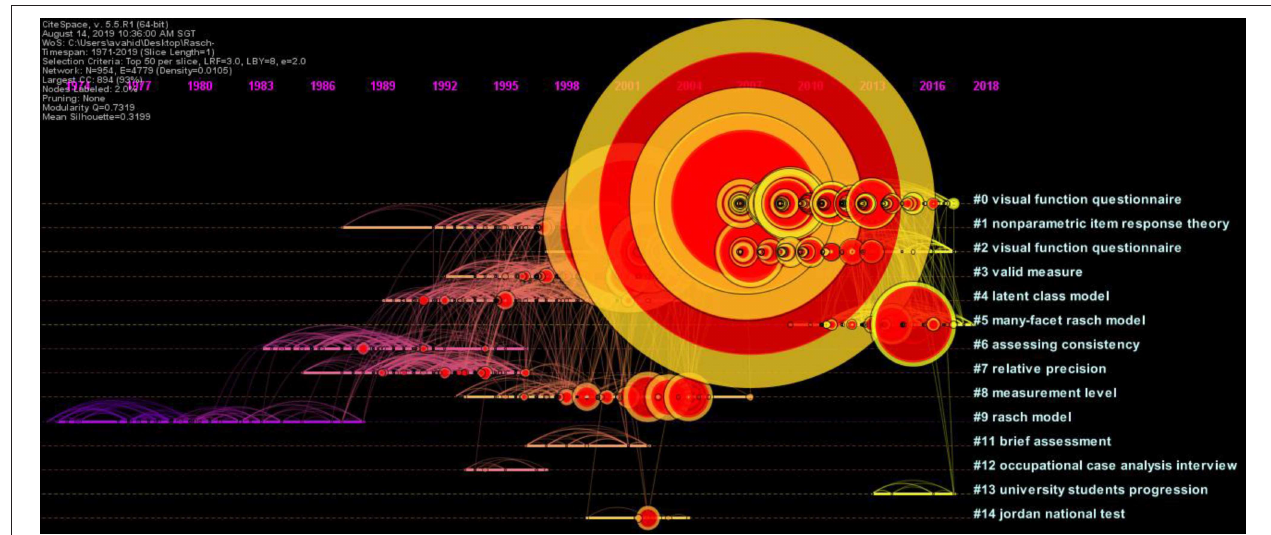
FIGURE 3 | Timeline view of the document co-citation analysis (DCA) network generated by CiteSpace (Chen, 2016a) (Modularity Q = 0.7319; average silhouette = 0.3199).